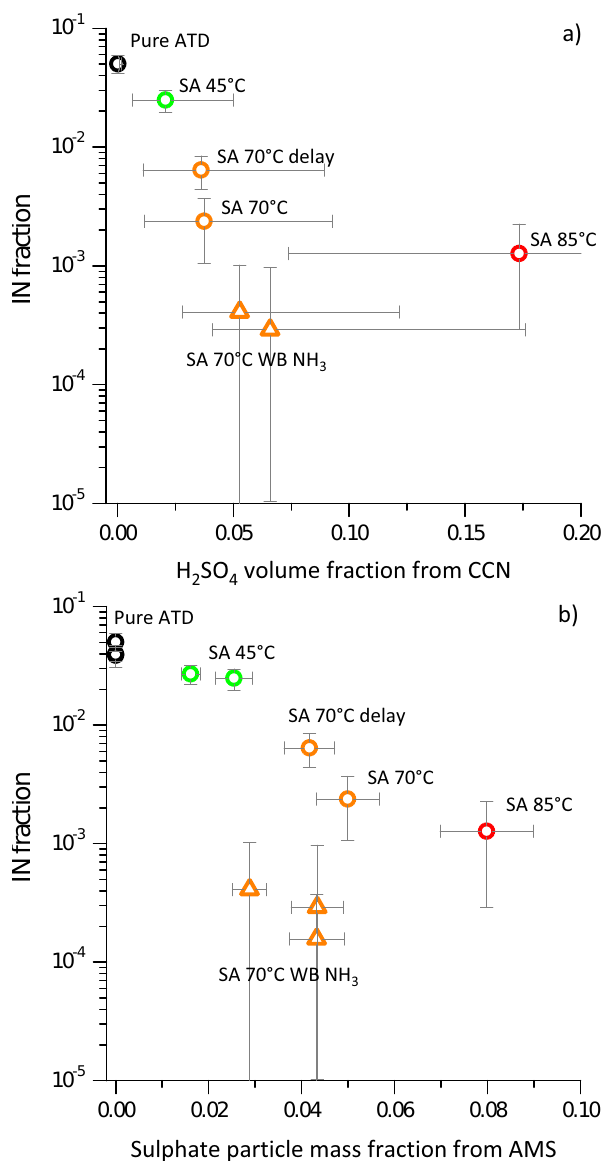
Fig. 3. Fraction of 300nm ATD particles that nucleated ice at − 30 ◦ C and RH w =105% (condensation/immersion-regime) after different treatment combinations, plotted versus (a) the particle’s sulphuric acid volume fraction estimated from the CCN hygroscop- icity measurements, or (b) the sulphate particle mass fraction esti- mated from the AMS measurements. Delay refers to experiments performed with an additional volume in the flow path to increase the treatment